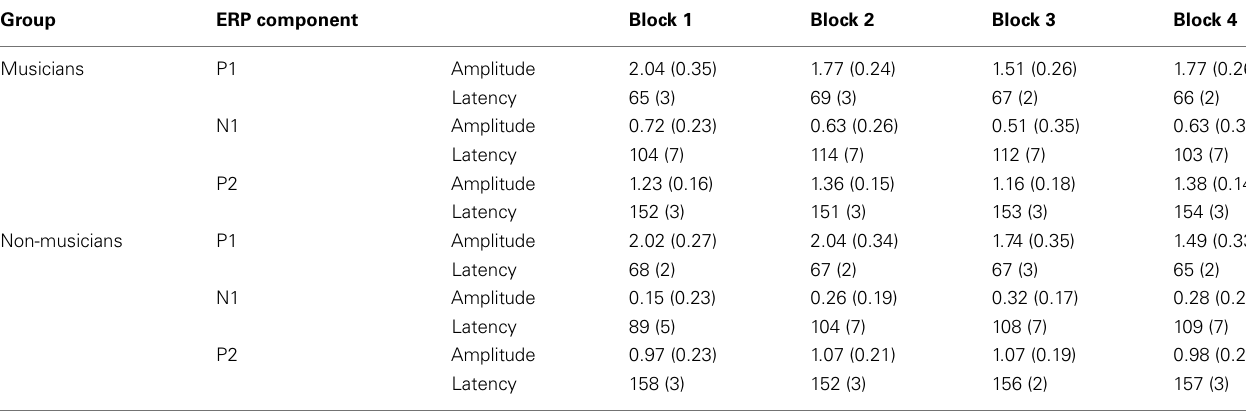
TableA3 | P1, N1, and P2 event-related potential mean amplitudes (microvolt) and peak latencies (ms) and their SEs of the means (in parentheses) for the standard stimuli from nose-referenced grand